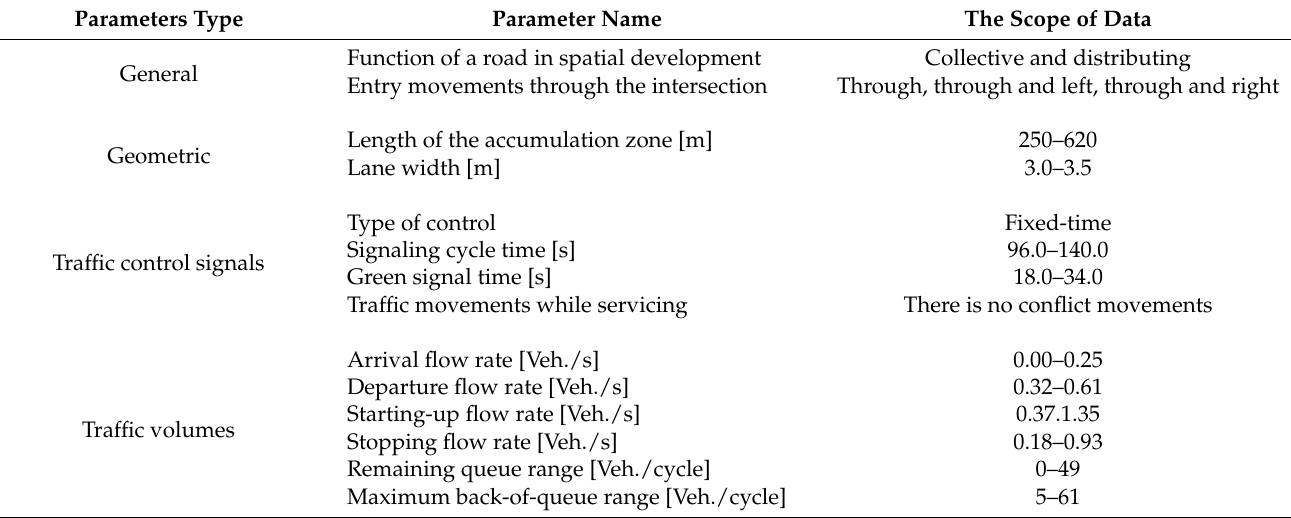
Table 1. The summary of the characteristics of the examined intersections and the collected